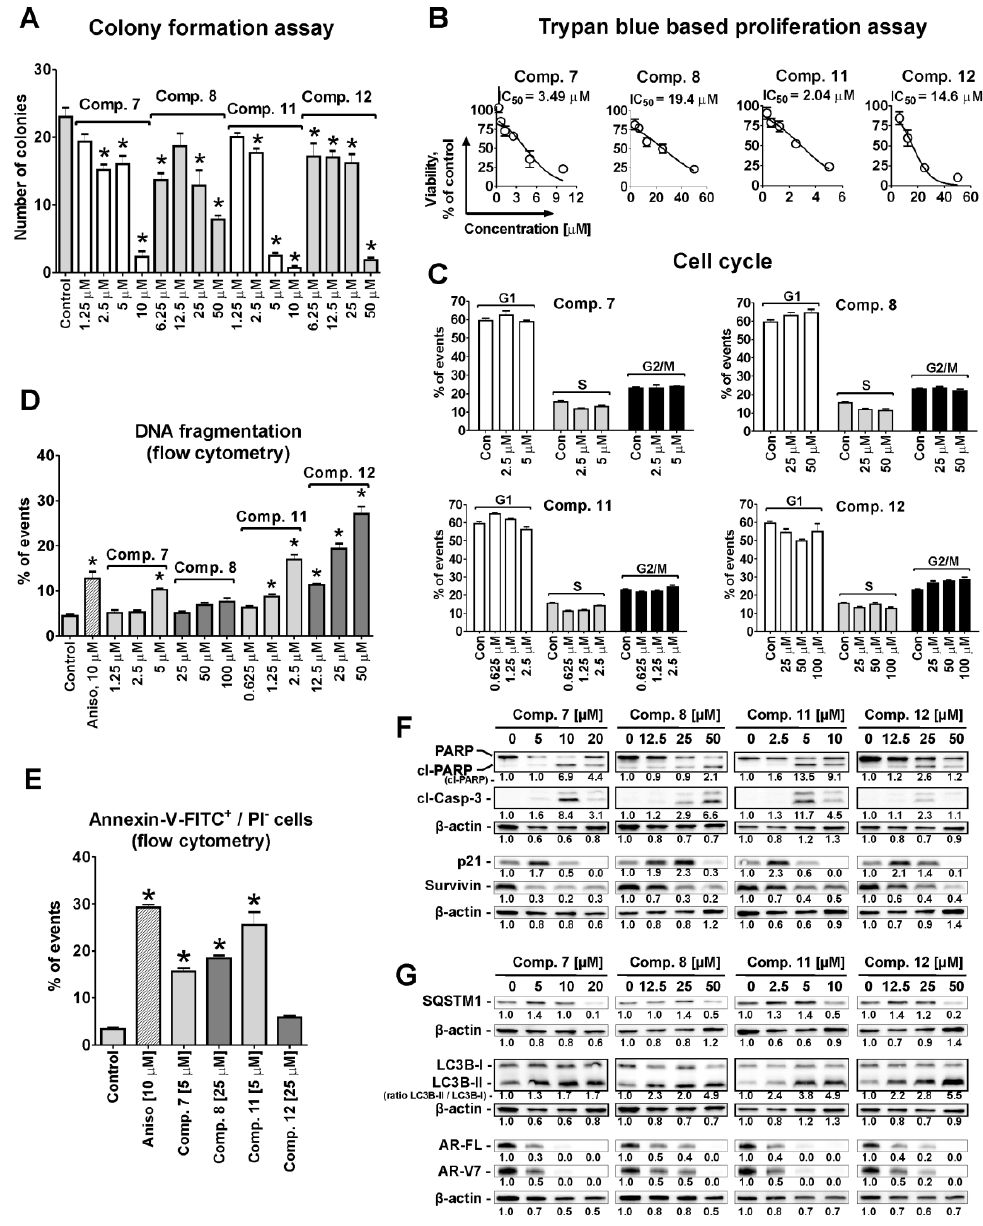
Figure 3. Cytostatic and proapoptotic activity of the selected conjugates. ( A ) Colony formation assay. The 22Rv1 cells were treated with the indicated concentrations of the compounds for 48 h, seeded in 6-well plates and incubated for 14 days. Cancer cell colonies were stained and counted by naked eye. ( B ), Cell viability and IC 50 s estimated in 22Rv1 cells using the trypan blue exclusion assay after 48 h of treatment. ( C – E ), Flow cytometry analysis of 22Rv1 cells treated with the investigated compounds for 48 h. ( C , D ), PI single staining: analysis of cell cycle. Apoptotic cells were detected as sub-G1 population ( D ). ( E ), Annexin-V-FITC/PI double staining. Cells appeared in low right quadrant (Annexin-V-FITC + /PI - ) were considered to undergo early apoptosis. Flow cytometry data were analyzed and quantified using the Cell Quest Pro software. ( F , G ), The Western blotting analysis of the expression of pro- and anti-apoptotic proteins ( F ) as well as autophagy and AR-signaling related proteins ( G ) in 22Rv1 cells after 48 h of treatment. β-actin was used as a loading control. Cells treated with 10 µM of anisomycin (Aniso) for 48 h were used as a positive control. Statistical significance: * p < 0.05 (ANOVA followed by a post-hoc Dunnett’s test). Detailed information of Figure 3F,G (Western blotting) can be found at Figure